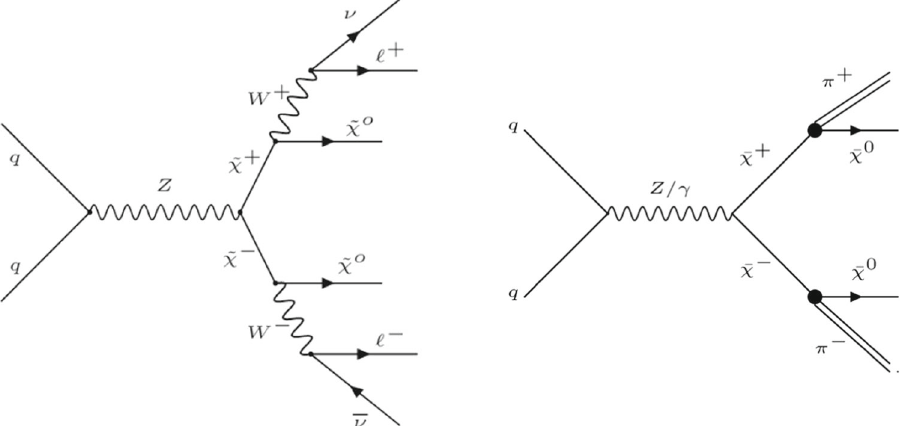
tion in the E 6 SSM (solid black) and SM (dashed red) at the LHC with √ s = 14 TeV (here, we also give the statistical error for the E 6 SSM case assuming 6000 fb − 1 of luminosity). The lightest (heaviest) of the two Z (cid:2) BPs considered here is on the left (right)